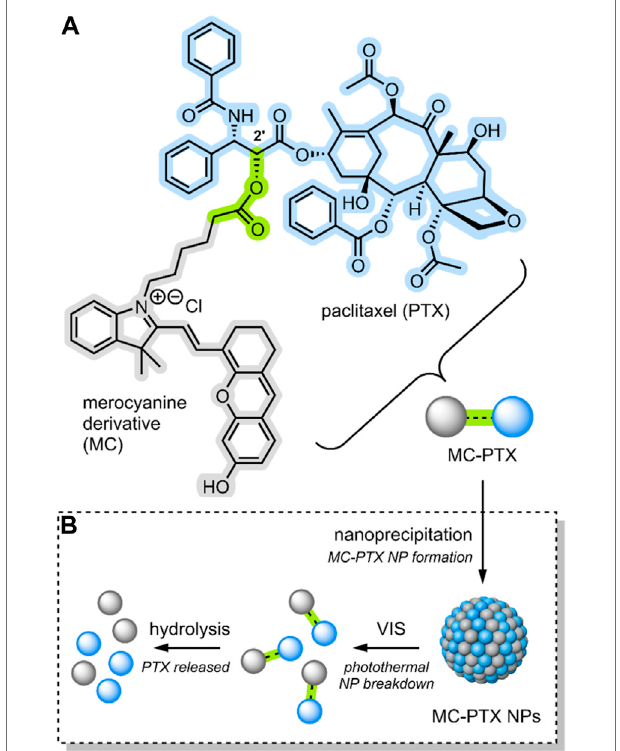
FIGURE6|(A) Ananthracene-likederivative ofMCandPTXconjugated through an ester linkage at the 2 ′ position to form MC-PTX. (B) MC-PTX conjugates self-assemble into MC-PTX NPs through a nanoprecipitation process. VIS light irradiation of MC-PTX NPs results in NP breakdown and a rise in temperature (photothermal effect). The MC-PTX ester linkage is hydrolysed by cytosol enzymatic activity, resulting in PTX release (Liu et al., 2021). MC, PTX and the ester linkage have been highlighted grey, blue and